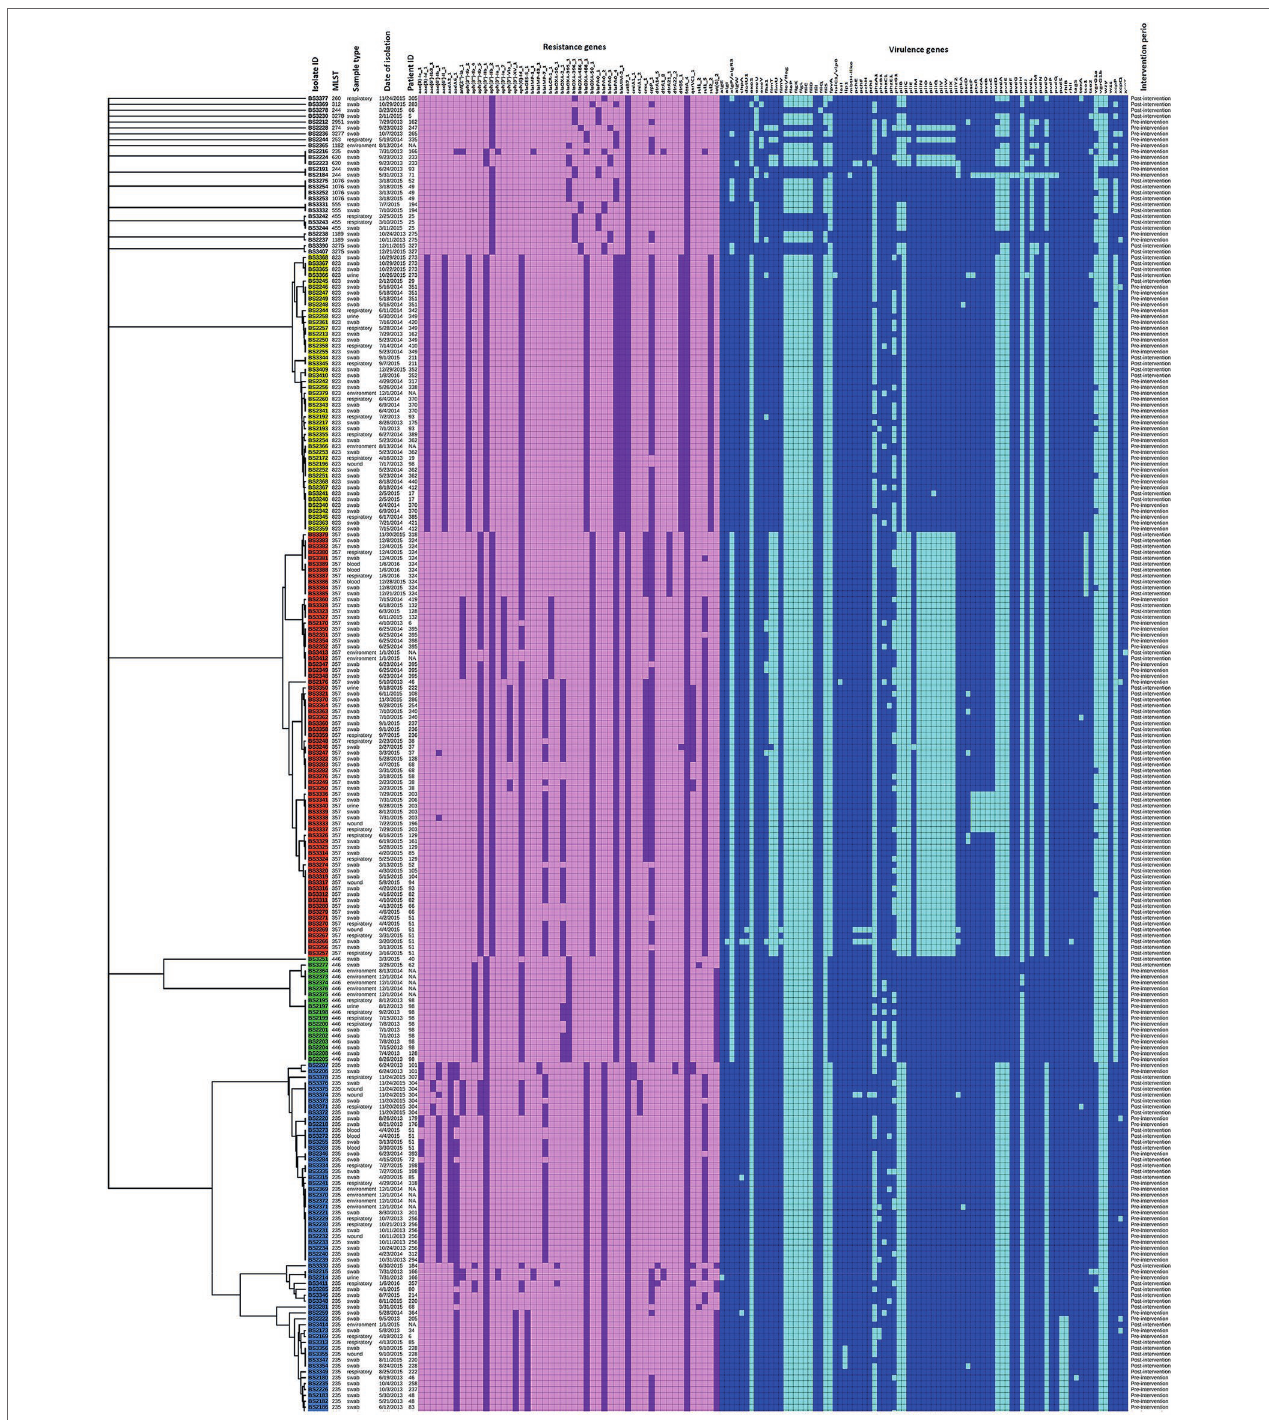
FIGURE 3 | wgSNP-based phylogenetic relationship between CNPA isolates. Major MLST groups are shown with different colors (yellow: ST823; red: ST357 and blue: ST235). Resistance and virulence genes are presented in the form of heat maps with purple and blue color ranges. Epidemiological and clinical data includes isolate ID, MLST, date and source of isolation (patients, environment and sample type) and intervention period are also mentioned along with the